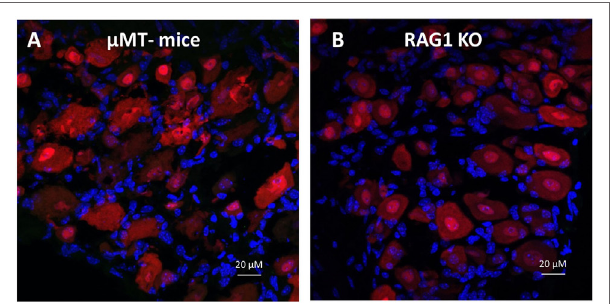
FigUre 6 | Dorsal root ganglion (DRG) neurons from mice deficient in B cell-derived IgGs [ μ Mt and Rag1 knock out (KO)] lack antigen-specific IgG immunoreactivity. Immunohistochemical staining of whole DRGs isolated from alum + KLH-immunized μ Mt (a) and Rag1 KO (B) mice stained for neurons (NeuN, red), IgG (green), and nuclei (DAPI, blue), 400 × magnification; scale bar = 20 µm.